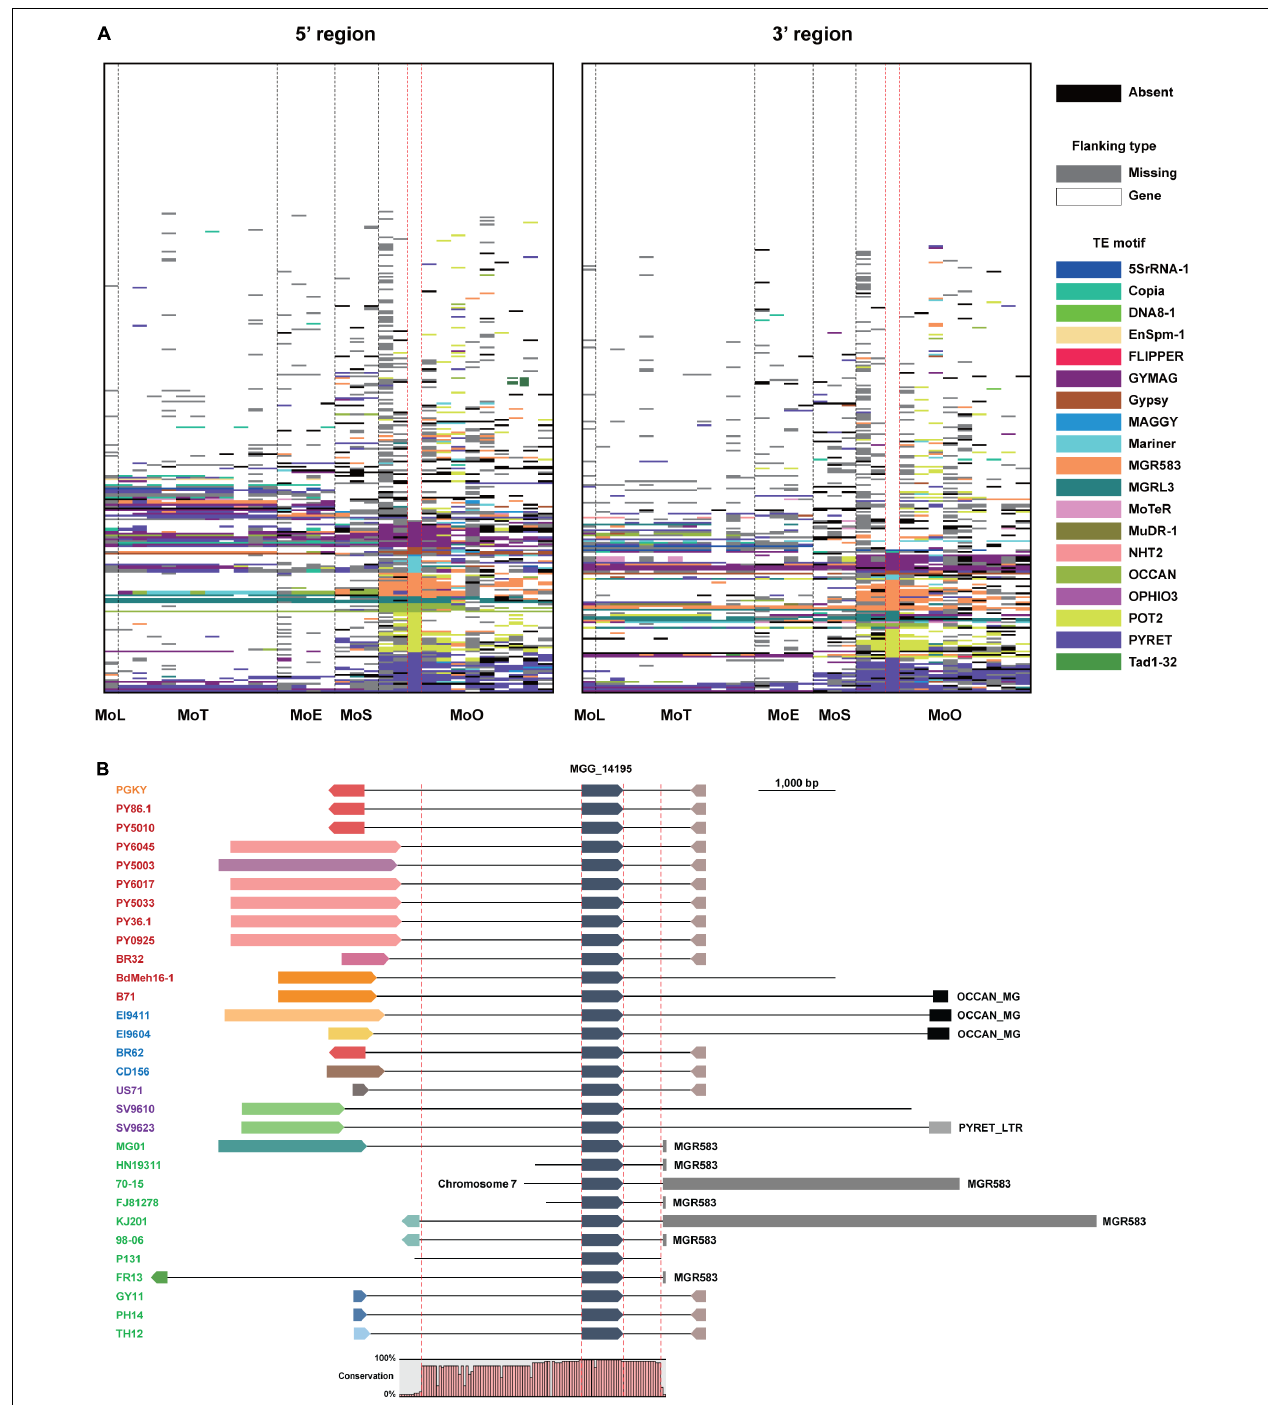
FIGURE 4 | Transposable elements flanking the EFC genes in different M. oryzae isolates. (A) Transposable elements (TEs) present at the 5 (cid:48) and 3 (cid:48) regions of the EFC genes in different pathotypes are shown. Those present in strain 70-15 are shown between dashed red lines. The absence of each EFC is noted black, and the presence of a gene in its flanking regions is noted in white. If there is no element in flanking regions of EFC due to the end of a contig, it is shown in gray. Different TE motifs are denoted using multiple colors. (B) The flanking regions of MGG_14195 in strain 70-15 and its homologs in other M. oryzae isolates are shown. The isolates analyzed are color-coded: MoO (green), MoS (purple), MoE (blue), MoT (red), and MoL (orange). They were presented following the order shown in the phylogenomic ( Figure 1A ). The directionality of the gene and flanking genes are indicated. The conserved region in their sequences was examined using Mugsy, a genome alignment tool (Angiuoli and Salzberg, 2011). The whole contig alignment shows the region covering the gene, and its conserved flanking regions are shown between red dashed red lines (2,551 and 553 bp).